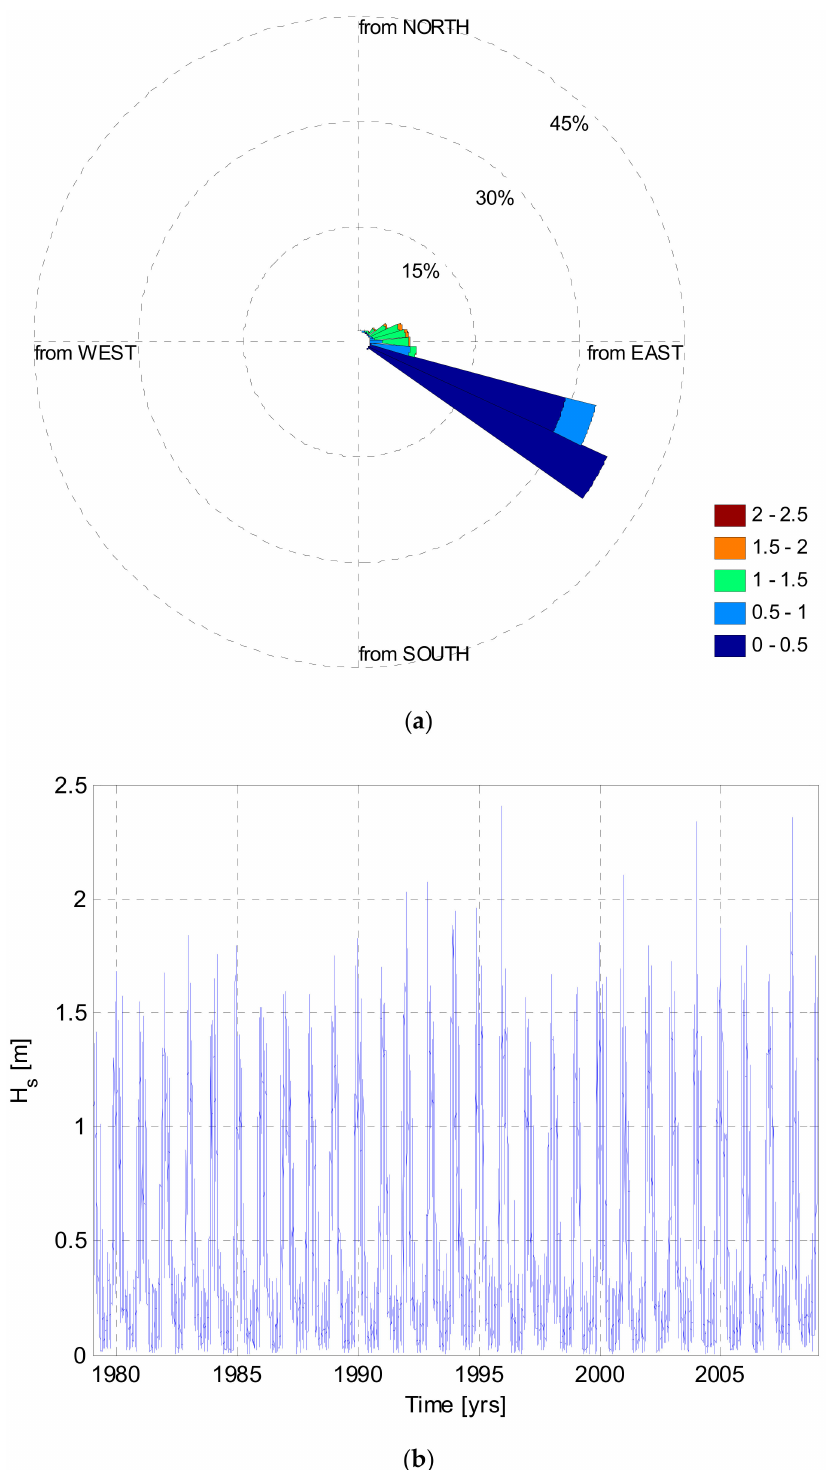
Figure 6. Nearshore transformed wave rose ( a ), and 30 years of extracted nearshore wave heights ( b ) in front of the Dutch Bay in Trincomalee at the location with 38 m